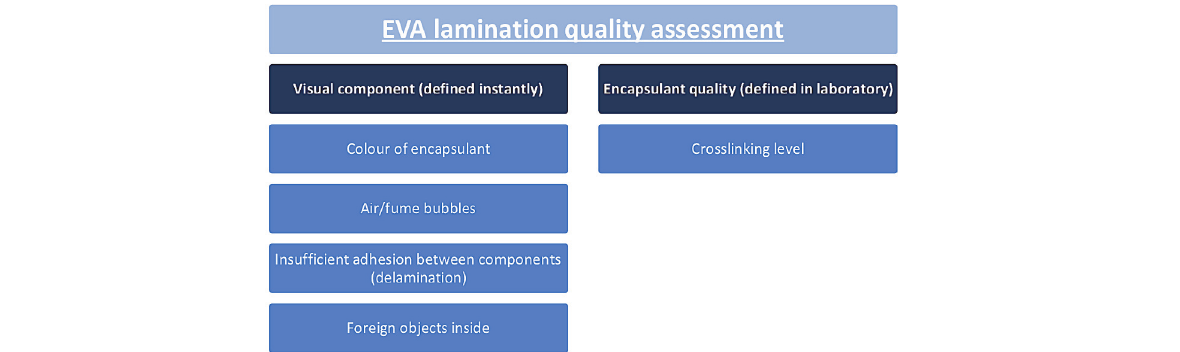
Fig. 2. Quality assessment of cured ethylene/vinyl acetate.